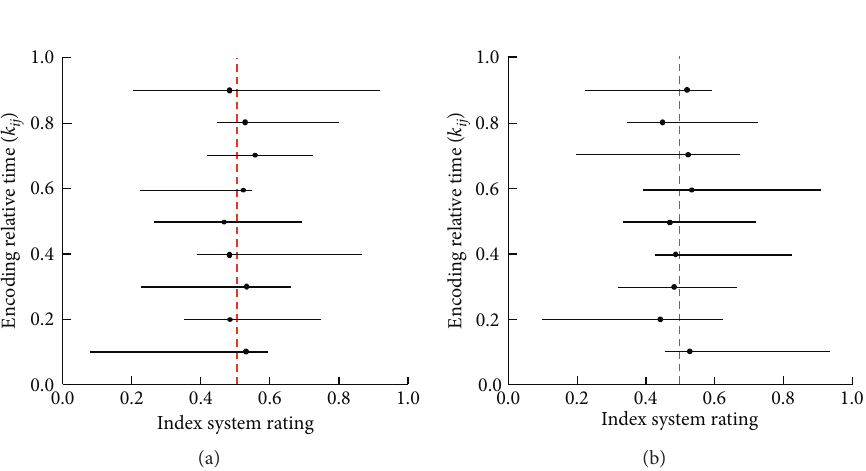
Figure 2: Relationship between encoding relative time and index system rating in the (a) resource scheduling and (b) strategic management of smart city based on digital economy.